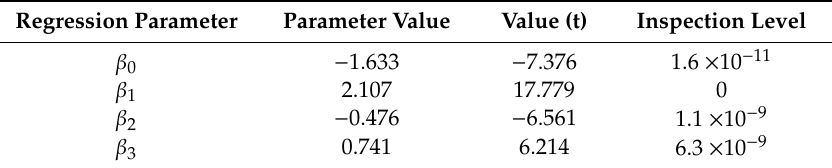
Figure 17. The relation between stress concentration factor and pitting ratio. SCF, stress concentration Figure17. Therelationbetweenstressconcentrationfactorandpittingratio. SCF,stressconcentrationfactor. factor. Table 4. Parameter values of the multidimensional linear regression